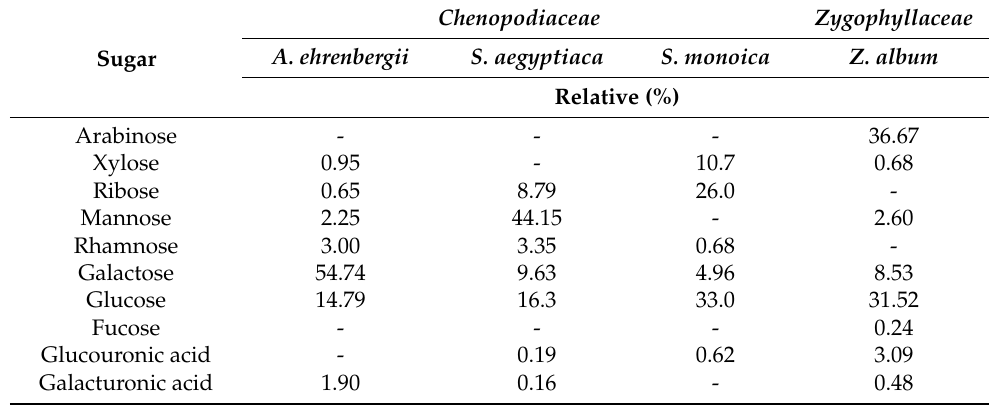
Table 1. Monosaccharide compositions of polysaccharides from the Red Sea halophytes *.